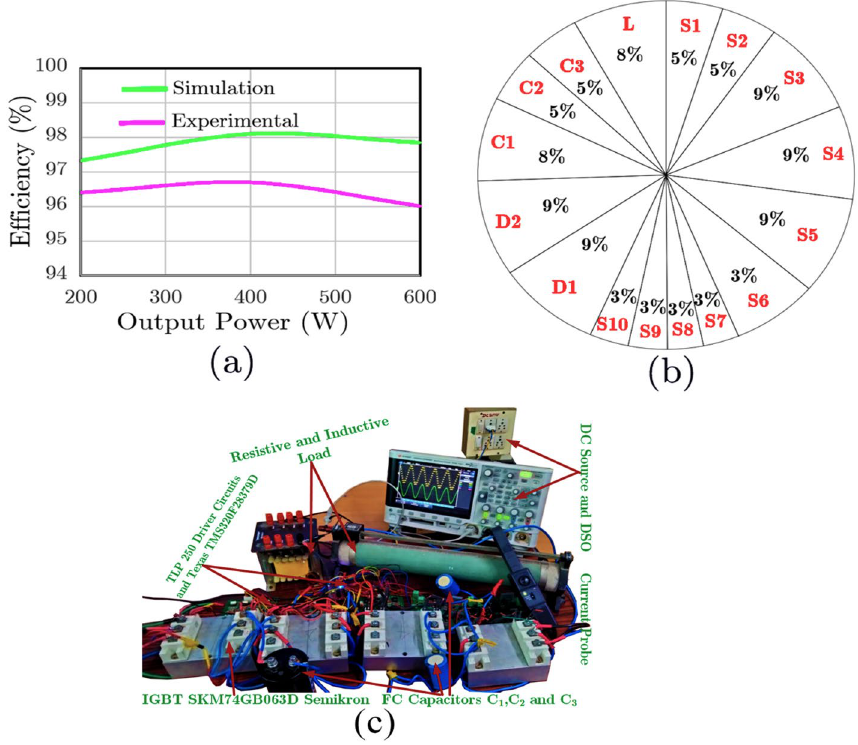
Figure 11. Power Loss ( a ) component loss breakdown using PLECS for 500 W, ( b ) Efficiency curve for unity power factor and ( c ) Scaled experiment